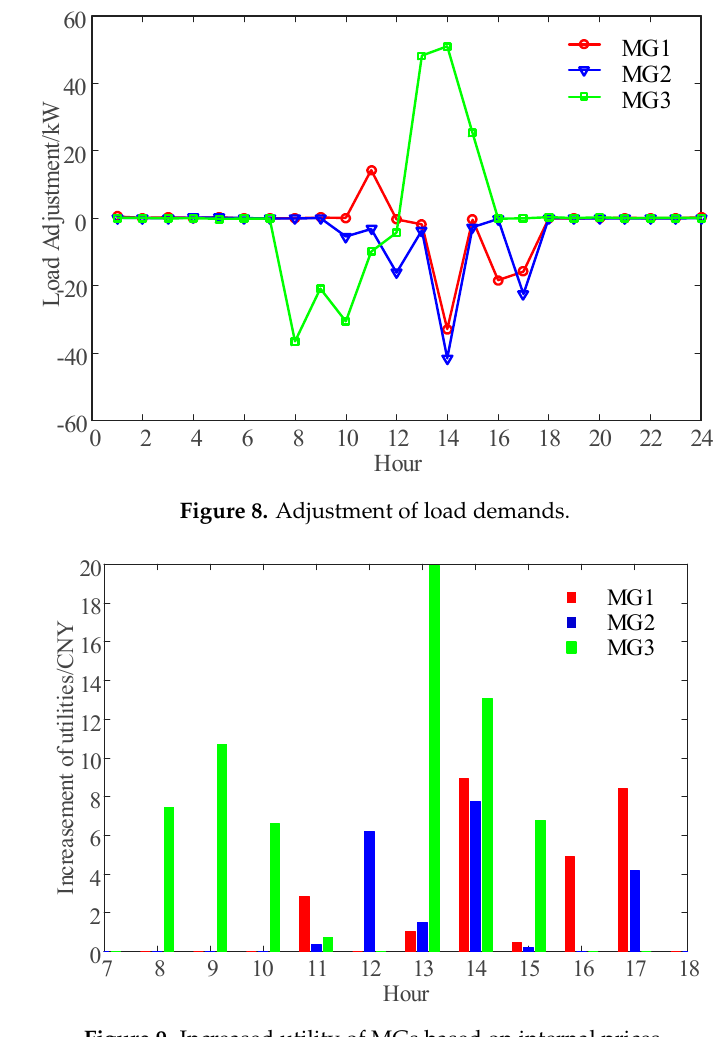
Figure 9. Increased utility of MGs based on internal prices.